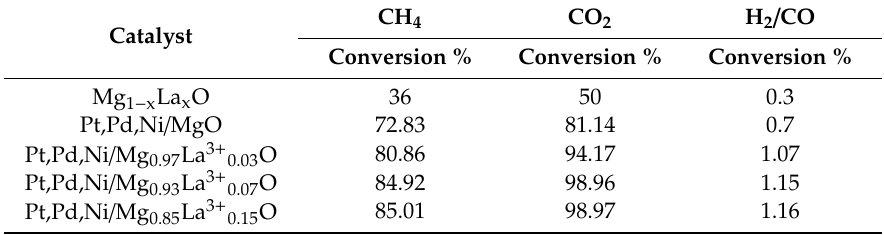
Figure 9. The e ff ect of using di ff erent catalysts ( a ) Pt,Pd,Ni / MgO, ( b ) Pt,Pd,Ni / Mg 0.97 La 23 + 0.03 O, Figure 9. The effect of using different catalysts ( a ) Pt,Pd,Ni/MgO, ( b ) Pt,Pd,Ni/Mg 0.97 La 23+0.03 O, ( c ) Pt,Pd,Ni/Mg 0.97 La 23+0.07 O, and ( d ) Pt,Pd,Ni/Mg 0.85 La 3+0.15 O on CH 4 , CO 2 conversion, and H 2 /CO ratio at ( c ) Pt,Pd,Ni / Mg 0.97 La 23 + 0.07 O, and ( d ) Pt,Pd,Ni / Mg 0.85 La 3 + 0.15 O on CH 4 , CO 2 conversion, and H 2 / CO 900 °C for the 1:1 ratio of CH 4 :CO 2. ratio at 900 ◦ C for the 1:1 ratio of CH 4 :CO 2 . Table 4. The catalytic results of DRM reaction for the catalysts at 900 ◦ C for the 1:1 ratio of CH 4 :CO 2 .